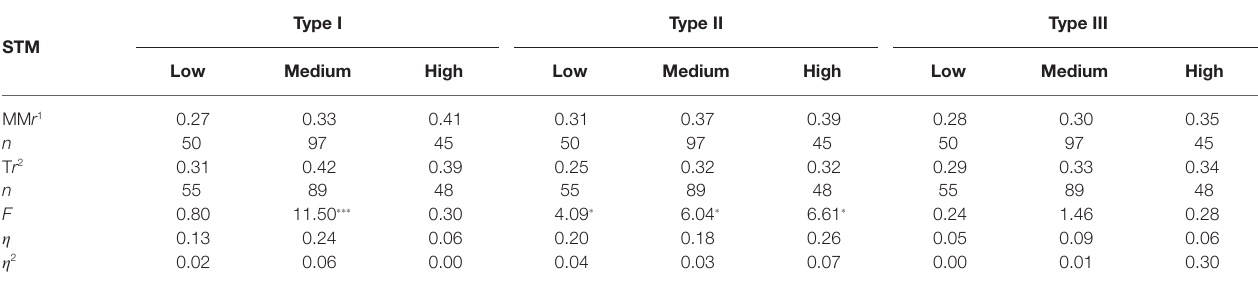
TABLE 5 | Relative values for learning outcomes from multimedia (MM r ) with three types of instruments and text (T r ) for three STM capacity levels.